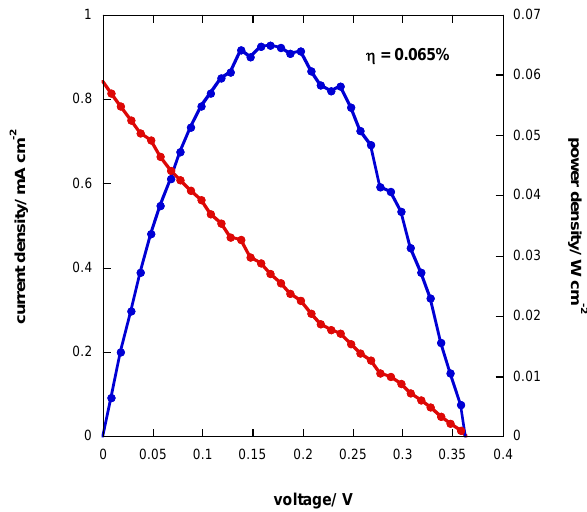
Figure 11. J ‐ V curve ( red line ) and power density ( blue line ) of photoelectrochemical cell.